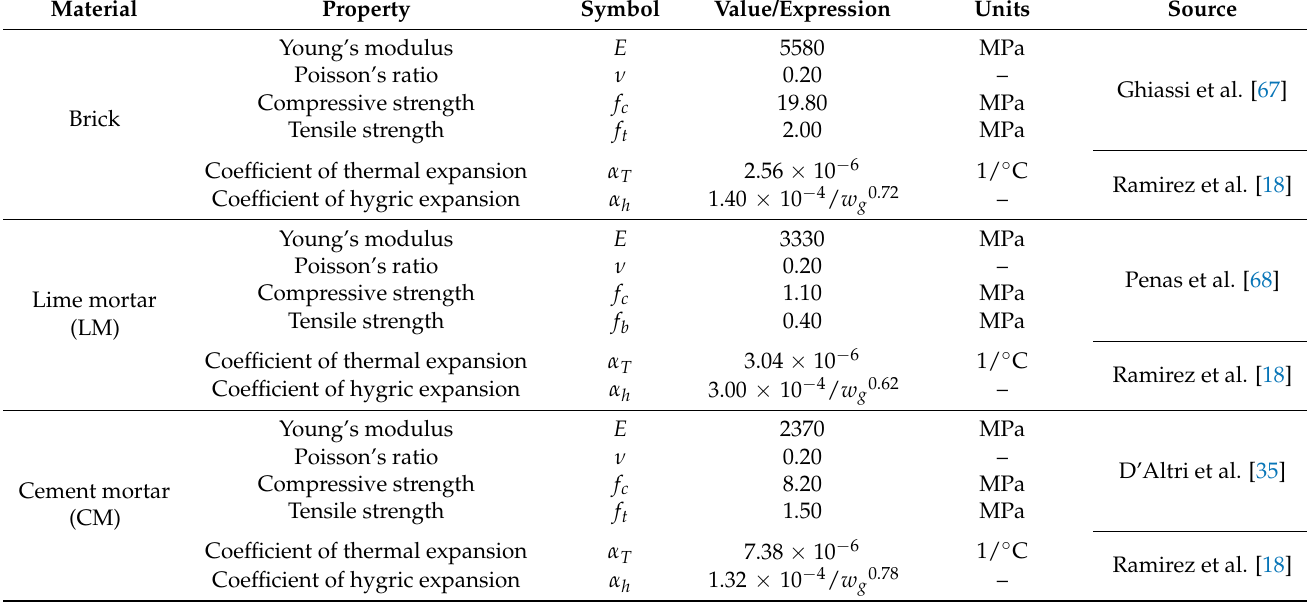
Table 3. Summary of mechanical, thermo-mechanical, and hygro-mechanical properties used for the hygro-thermo-mechanical